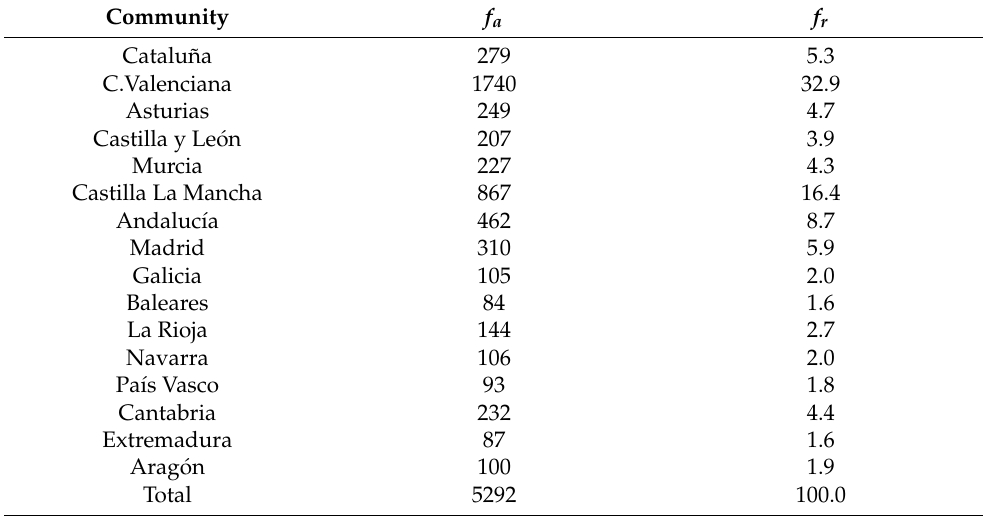
Table 1. Frequency distribution of participants by autonomous